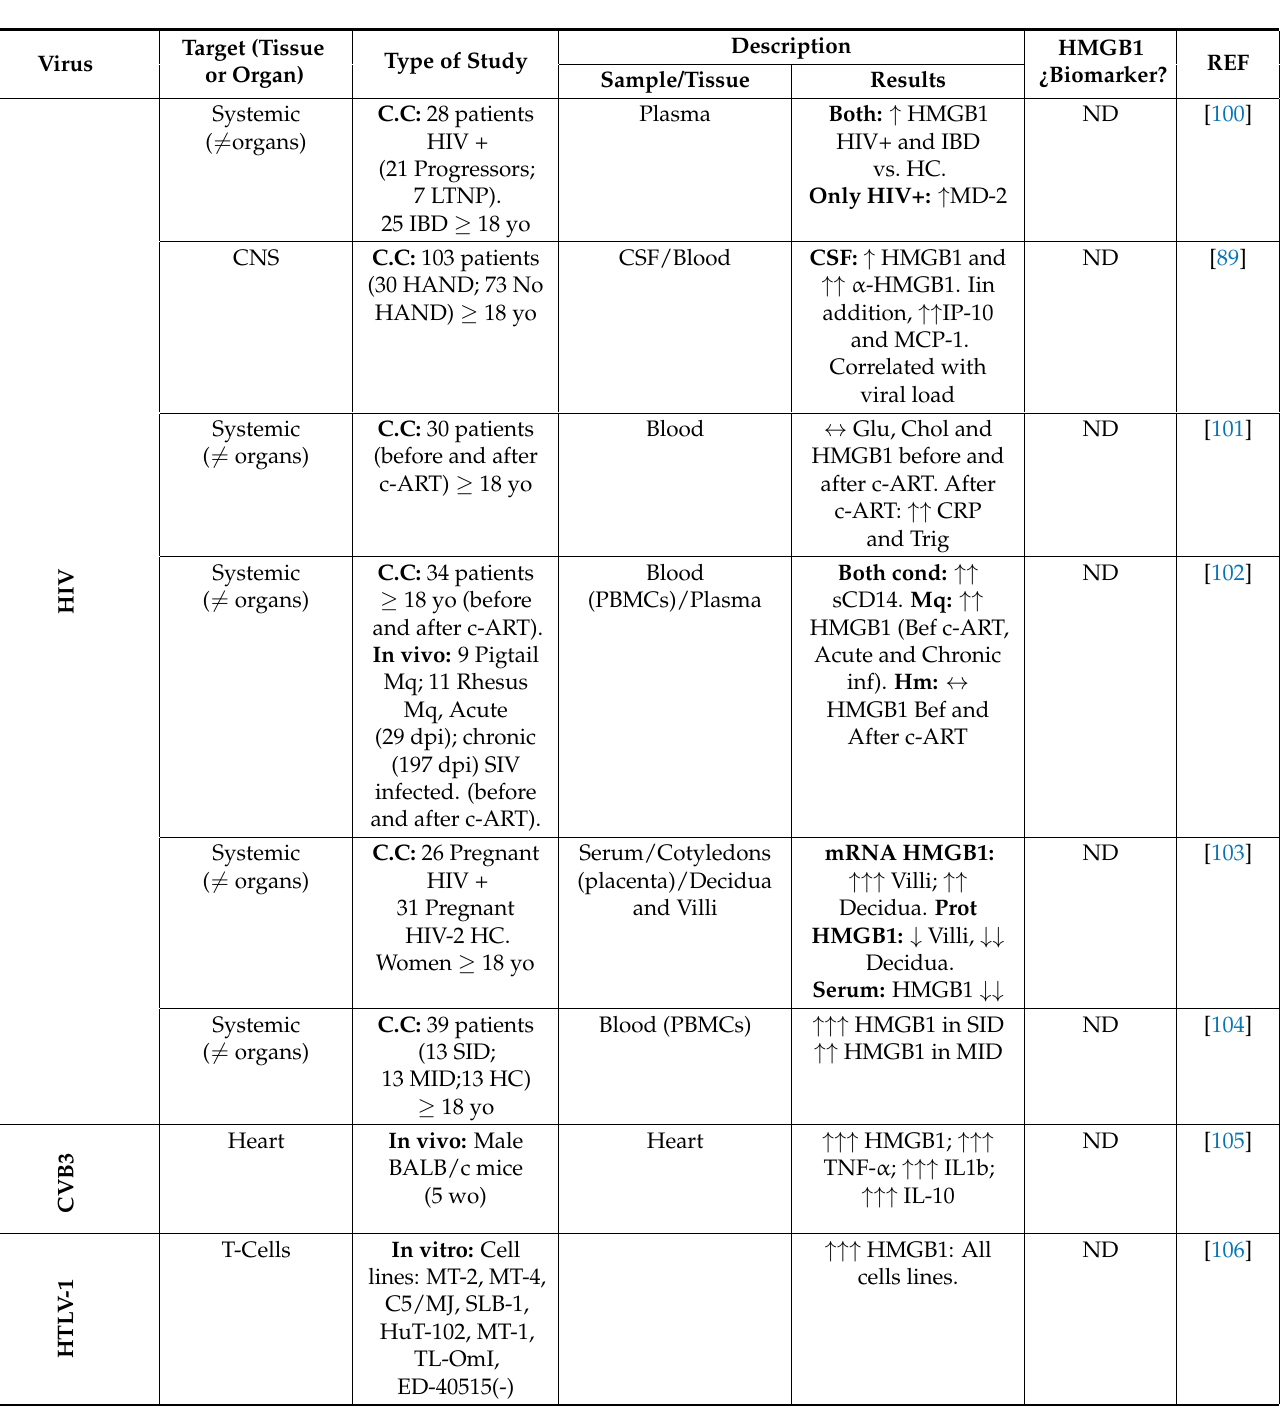
Table 2. HMGB1 in other viral